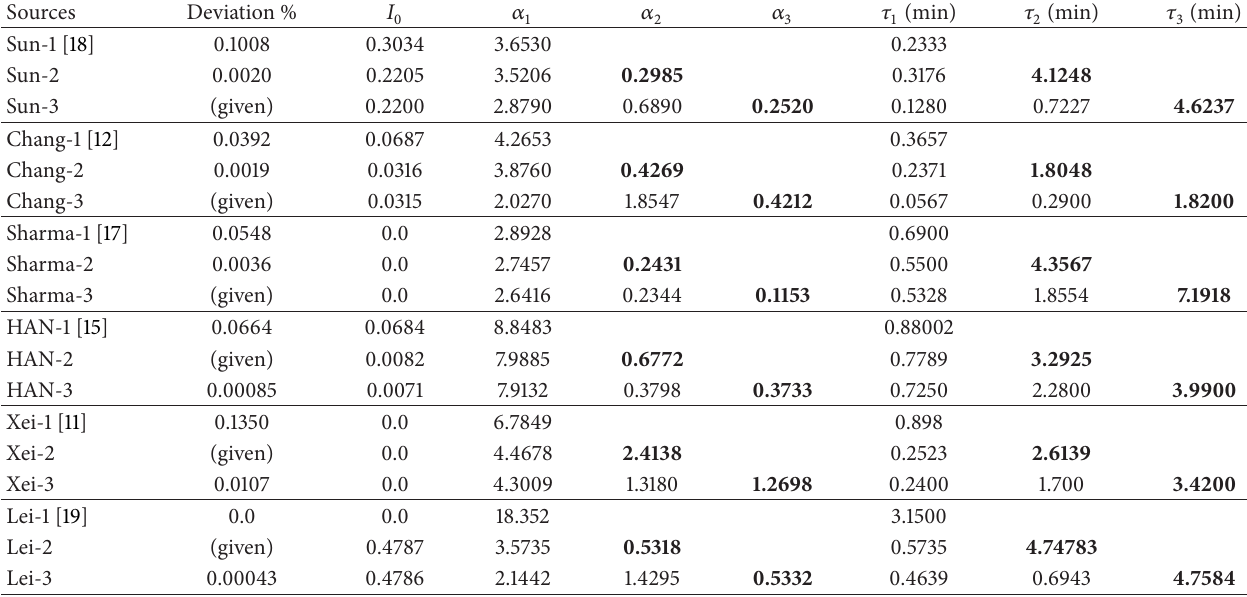
Table 2: Fitting parameters of the decay curves by using the single, double, and triple exponential equations. -1, -2, and -3 indicate the use of single, double, and triple exponential equations in interpretation,